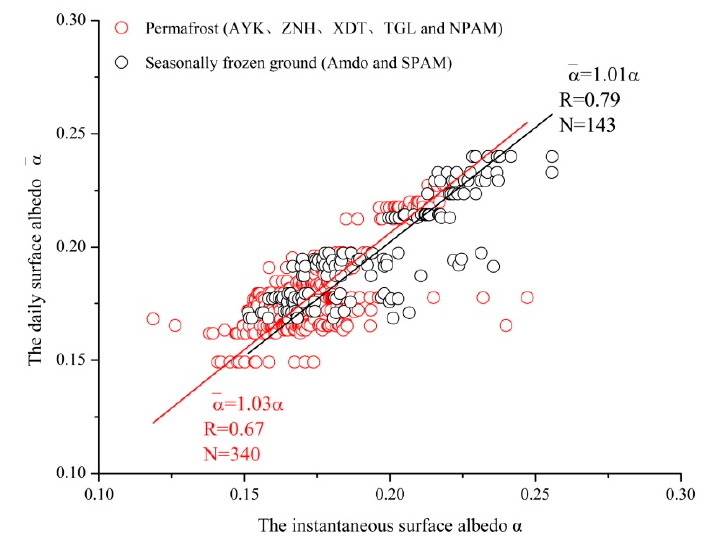
Figure 7. Relationship between the land surface albedo instantaneous value α and the daily mean value α ̅ in permafrost and seasonally frozen ground.